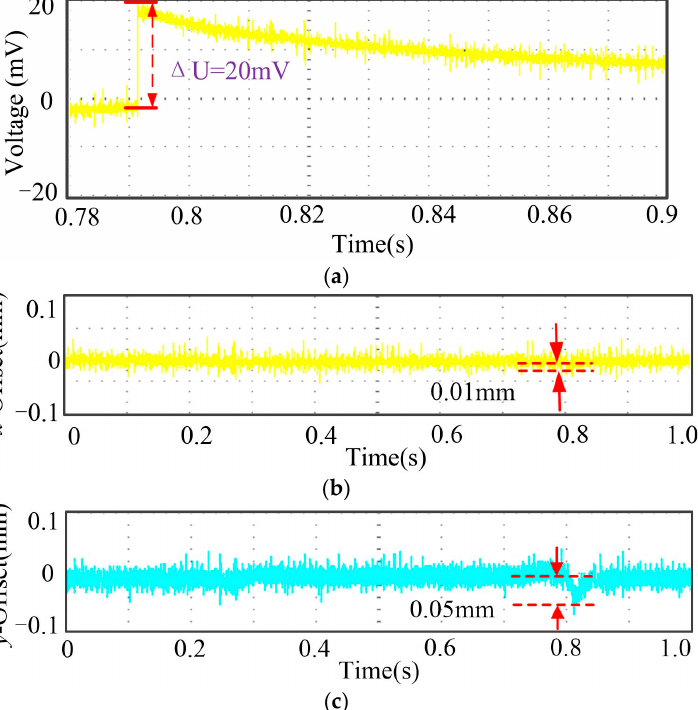
Figure 14. Experimental results in accelerated experiment. ( a ) The force signal output by vibration exciter. ( b ) Rotor offset in x direction. ( c ) Rotor offset in y direction.